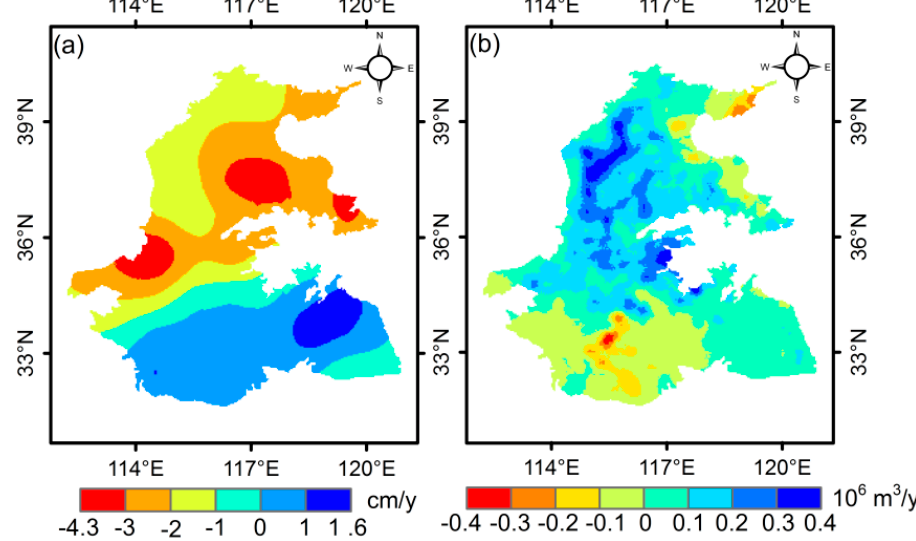
Figure 8. Change rates of ( a ) GRACE-derived GWSA from 2003 to 2015 and ( b ) WF blue anomalies of wheat from 2003 to 2009 in the 3H Plain.